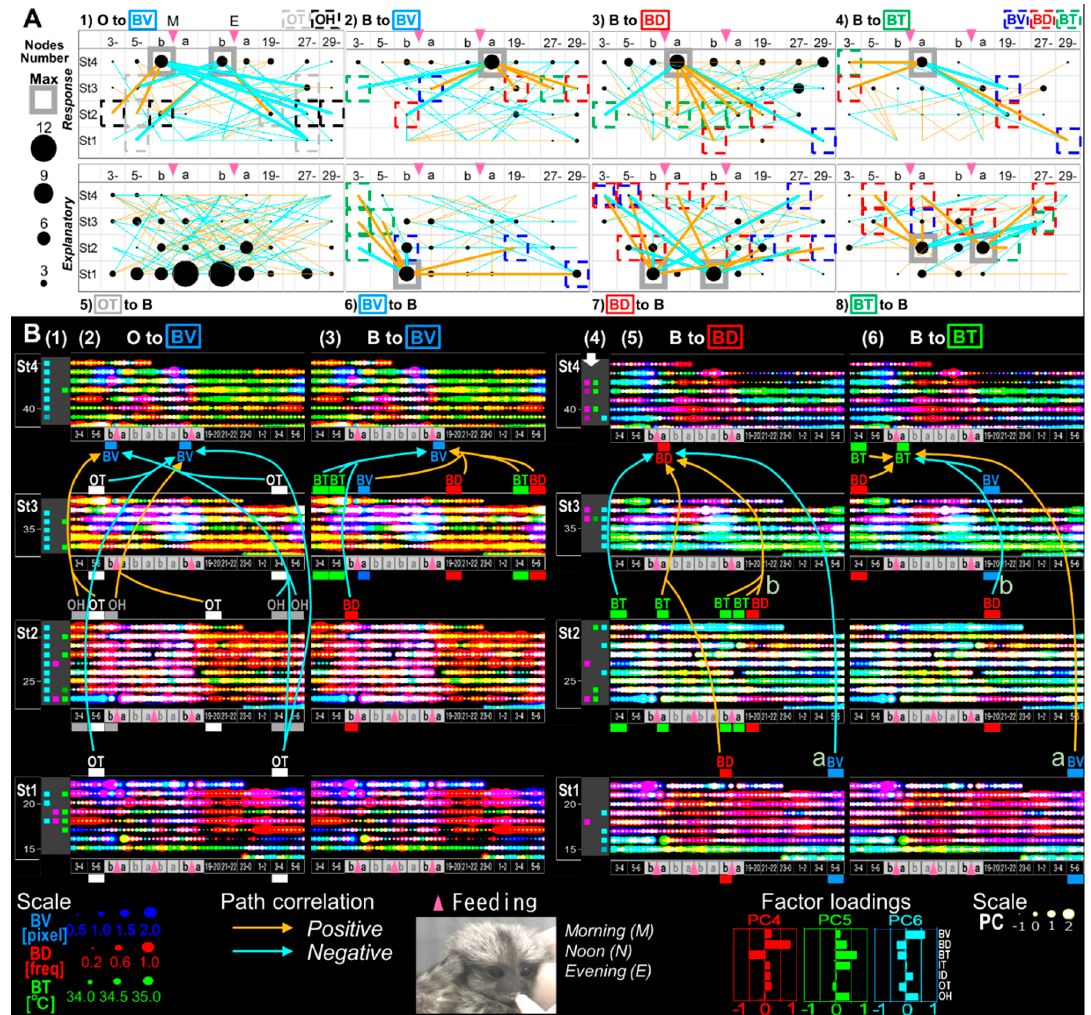
Figure 10. Feeding-dependent positive/negative pathways determined by LMMs on gradient or unique circadian development, on the basis of B(biological)-indices. ( A ) The numbers of explanatory or response variables (“nodes”) in each time point (horizontal axis; 3–4 (3-) and 5–6 (5-) a.m., before (b) and after (a) morning (M) and evening (E) feeding (pink arrow-head), 19–20 (19-) p.m., 27–28 (27-), 29–30 (29-) a.m.) are shown as circles, which estimate the effects of the variables. The effects as responses and explanatory variables are estimated by the regression of BV, BD or BT on arbitrary O- (1) or B- indices (2–4) and the regression of arbitrary B- indices on OT (5), BV, BD or BT (6–8; see also Figure 11). The maximum response nodes (MRNs) and maximum explanatory nodes (MENs) are marked by gray squares. ( B ) Overlaid 30-min-raster plot of BV (blue), BD (red) and BT (green; left side, 2–3) or PC4 (red), PC5 (green) and PC6 (blue; right side, 5–6), are displayed separately for each age stage. Significant light-dark differences in each day are shown as their own-colored squares on the left side (1), (4) of the raster plots ( p < 0.05 (lighter colors) and p < 0.1 (darker colors) by Tukey’s HSD test following two-way ANOVA). The BV MRNs pathways regressed on O- indices (B2), “O to BV” (A1)), BV regressed on B- indices (B3), “B to BV” (A2)), BD regressed on B- indices (B5), “B to BD” (A3)), and BT regressed on B- indices (B6), “B to BT” (A4)) extracted by LMMs followed by cAIC are also